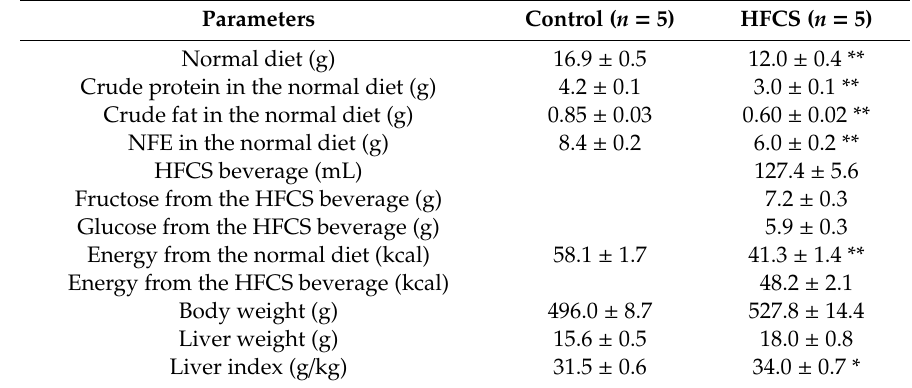
Table 1. Intake parameters of the normal diet and high fructose corn syrup (HFCS) beverage and body and liver